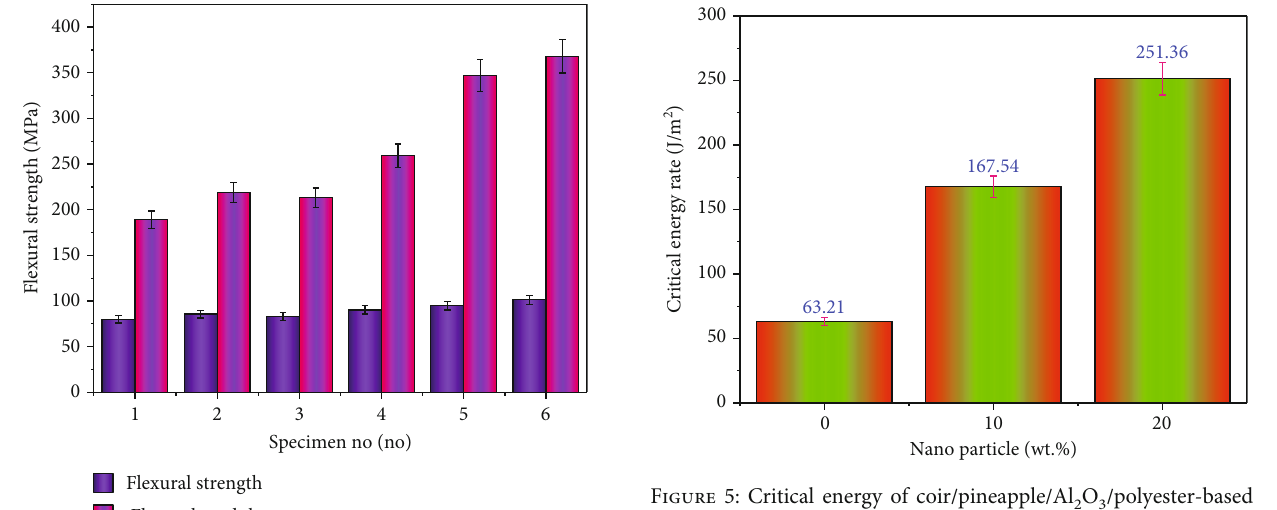
O /polyester-based 2 3